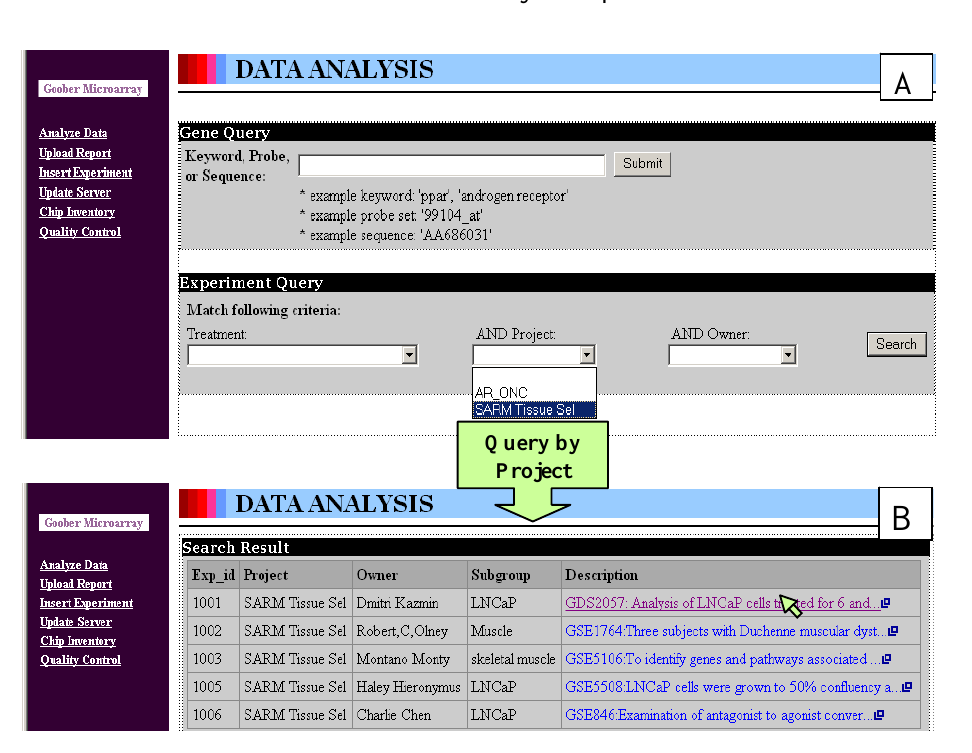
Figure 2: Experiment based query in Goober web interface. (A) The home page of Goober. The bottom area is used for conducting an experiment-based query. (B) The desired experiment one was selected by a mouse click (represented by the green